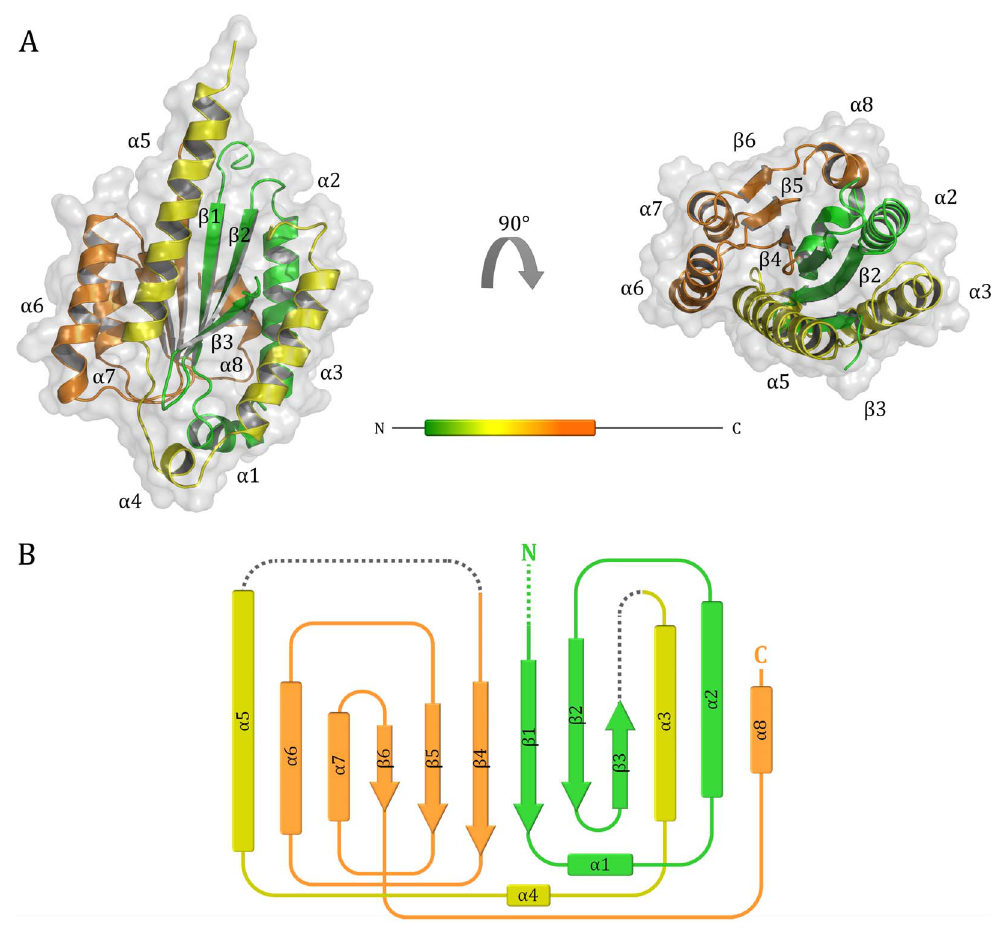
Figure 1. Overall structure of p34ct and analysis of the MIDAS region. (A) Front view of the p34ct 1–277 vWA domain (left) and view from the top (right) with the color coding corresponding to the N-terminal (green), central (yellow) and C-terminal (orange) part of the domain, respectively. The location of the vWA domain within full-length p34ct is indicated in the equally colored bar representation. (B) The topology diagram of the vWA fold shows that its architecture can be distinguished from a typical Rossmann fold by b -strand b 3, which is anti-parallel in all vWA domains.